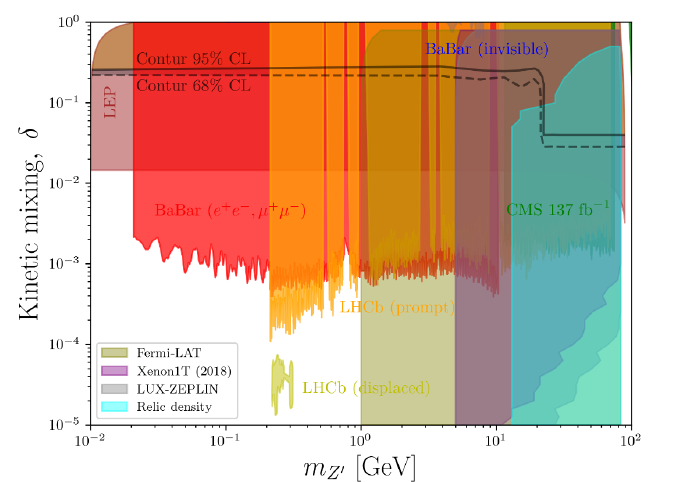
Figure 5 . The different recasted experimental constraints from LEP, BaBar, CMS, LHCb and (in)direct detection experiments for the light Z 0 case. We also show the 95% CL (solid line) and the 68% CL (dashed line) excluded regions from Contur as well as the relic density constraint. Here m D = 2 m Z 0 and so the limits correspond to the case of Z 0 decaying to SM fermions only and no dark decays of the Z 0